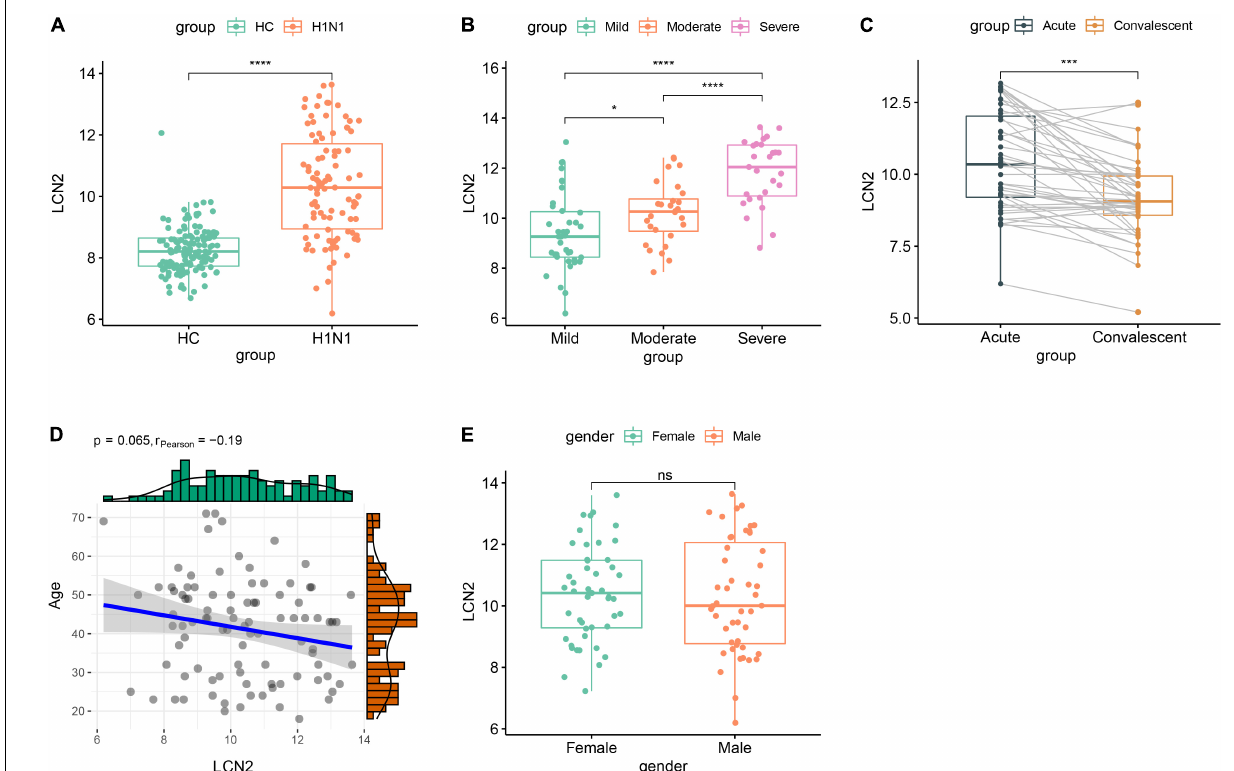
FIGURE 3 | Correlation between LCN2 and clinical features of IAV infection in public dataset. (A) Expression level of LCN2 in healthy controls and patients with IAV infection (GSE111368). (B) Expression level of LCN2 in patients with mild, moderate, and severe influenza. (C) Expression level of LCN2 in acute and convalescent patients with IAV infection. (D) Association of patients’ age with expression level of LCN2. (E) Expression level of LCN2 in female and male patients with IAV